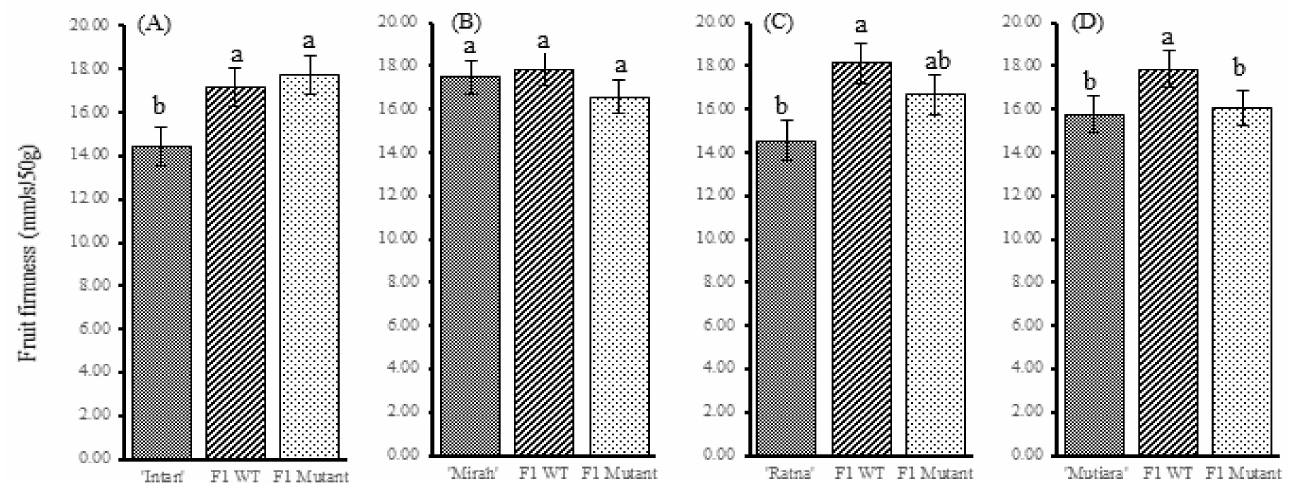
Figure 4. Fruit firmness of F1 generation from four tropical tomato genetic backgrounds. ( A ) ‘Intan’, ‘Intan’ × ‘WT’, and ‘Intan’ × Sletr1-2 ; ( B ) ‘Mirah’, ‘Mirah’ × ‘WT’, and ‘Mirah’ × Sletr1-2 ; ( C ) ‘Ratna’, ‘Ratna’ × ‘WT’, and ‘Ratna’ × Sletr1-2 ; ( D ) ‘Mutiara’, ‘Mutiara’ × ‘WT’, and ‘Mutiara’ × Sletr1-2 ; Value is means ± SE ( n = 4 × 5). Letters denote statistically distinguishable values as assessed by the HSD Tukey test p < 0.05.